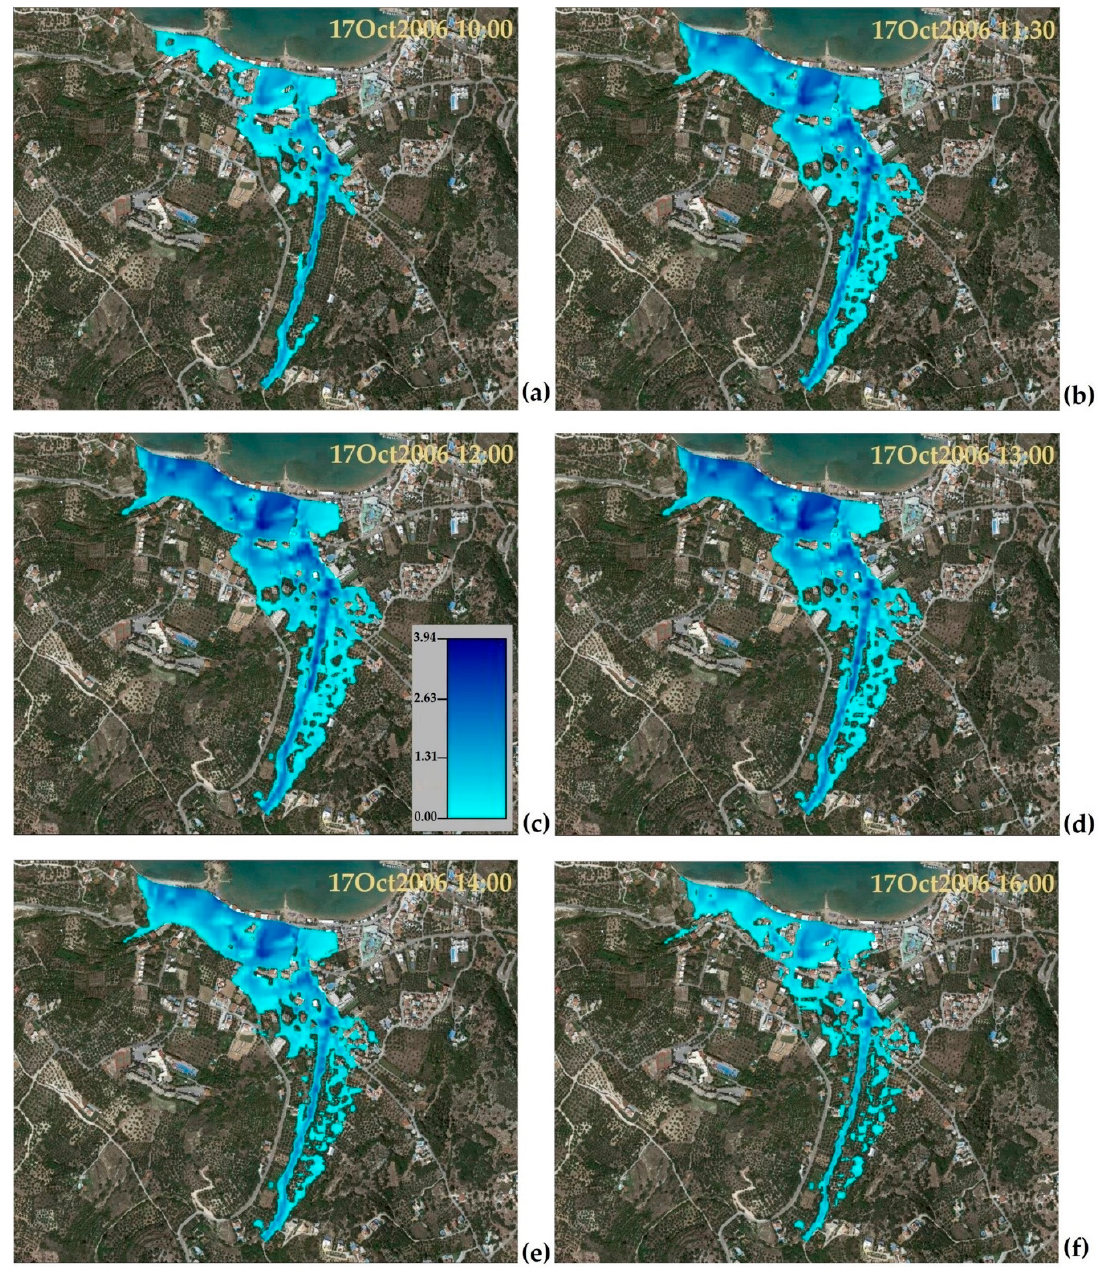
Figure 6. Modeled flood depths (m) at ( a ) 10:00, ( b ) 11:30, ( c ) 12:00, ( d ) 13:00, ( e ) 14:00, and ( f ) 16:00 of 17 October 2006, by using the coupled 1D/2D HEC-RAS model, at high resolution DEM 5 m × 5 m.